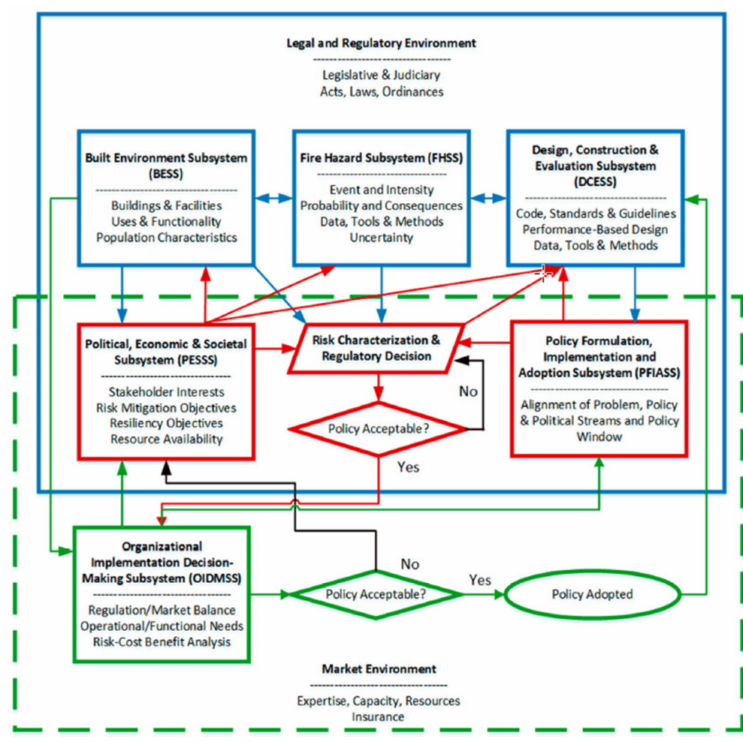
Figure 1. Representation of sociotechnical building regulatory system